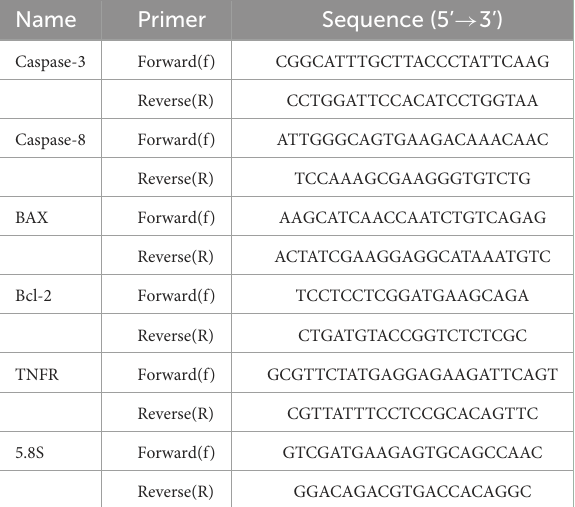
TABLE 1 Primers used in RT-qPCR for the expression analysis of five genes related to apoptosis in different developmental stages of Echinococcus granulosus . 5.8S was used as the reference